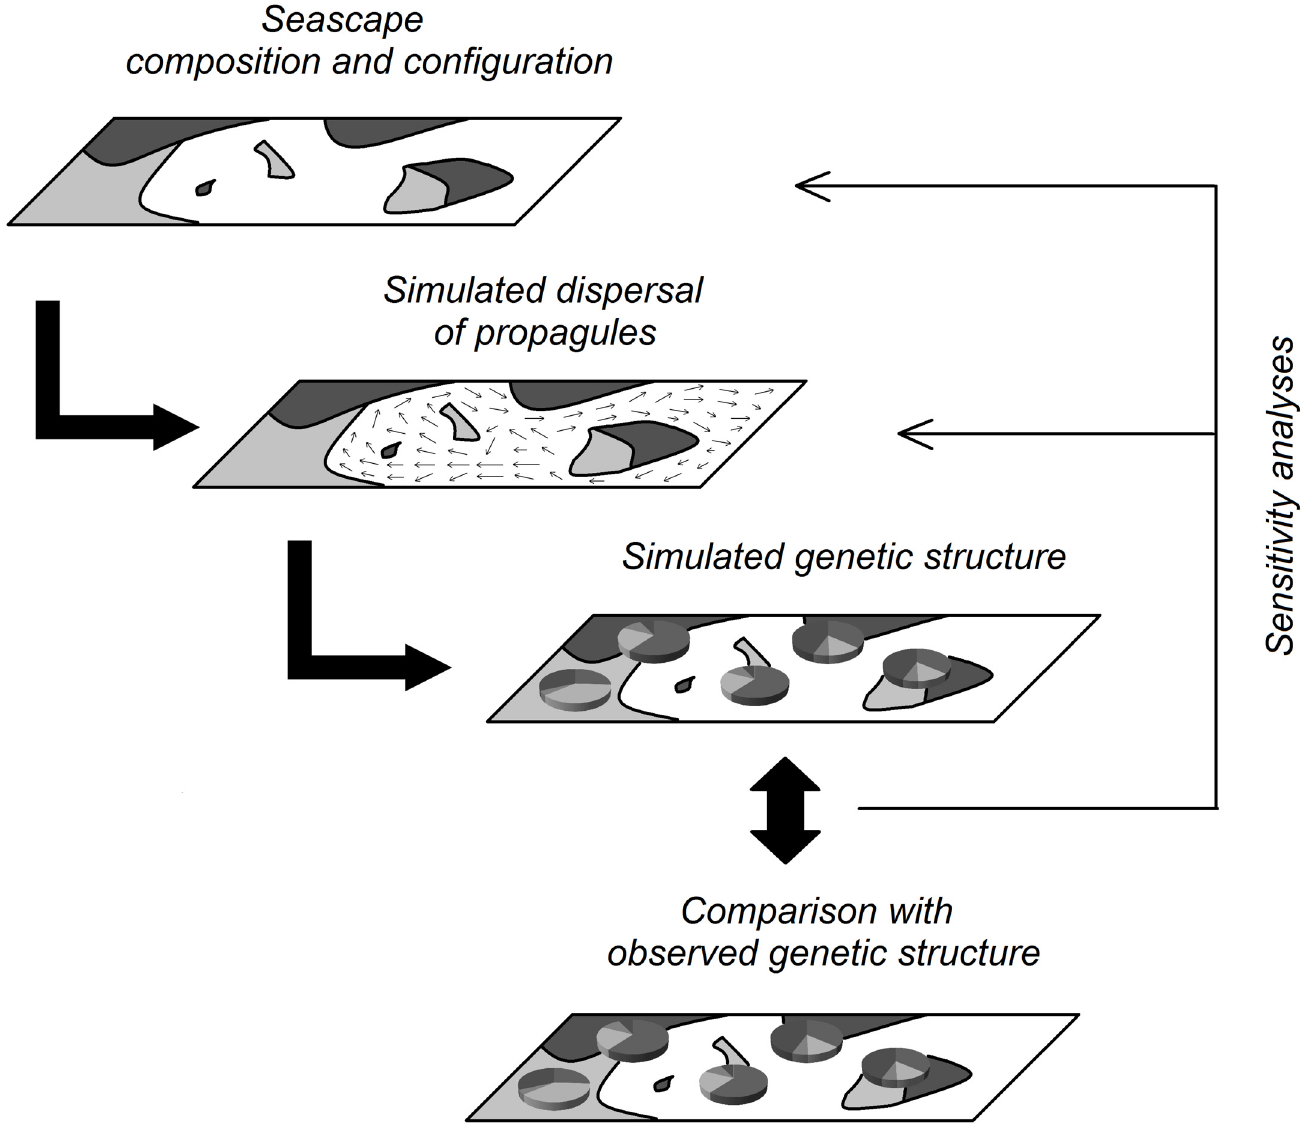
Fig 1. Modelling approach to explicitly test the influence of seascape composition and configuration on genetic structure. The relative influenceof the variousinput parameters (e.g., habitat distribution and type, dispersaldistanceor pelagiclarval duration) on geneticconnectivitycan be assessedquantitatively by performing sensitivity analysesof these parameters on the match betweenobservedand simulatedgeneticdivergences.